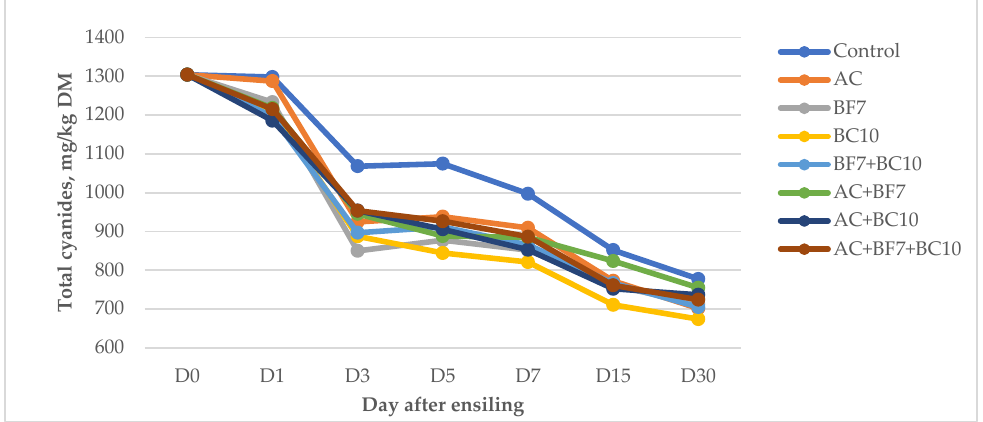
Figure 1. The changes in total cyanide content of cassava root silage during 30 days of ensiling. AC — Acremonium cellulase; BF7 — E. feacium KKU-BF7 inoculant ; BC10 — E. gallinarum KKU-BC10 inoculant.